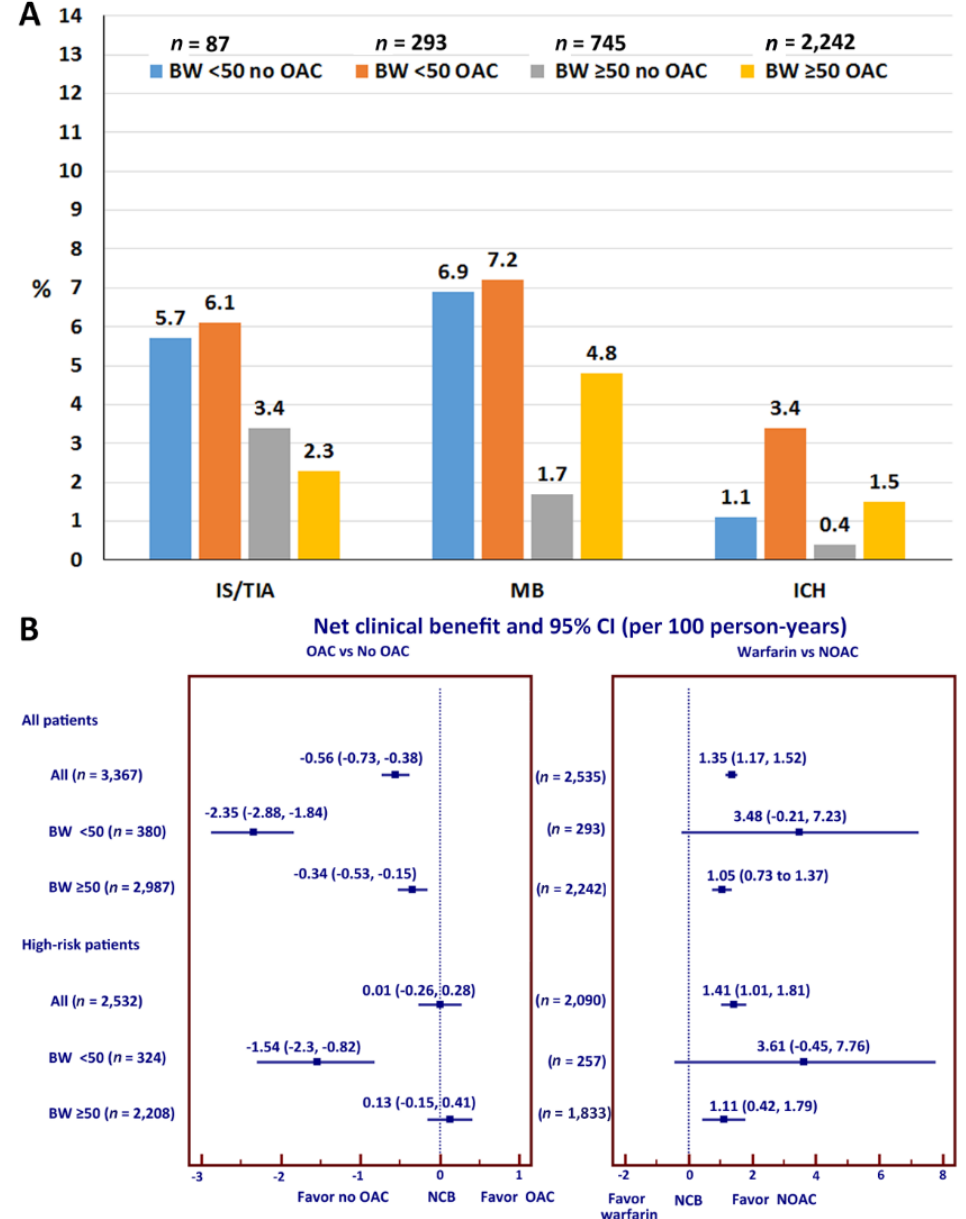
Figure 5. Oral anticoagulants and clinical outcomes. ( A ). Rates of ischemic stroke (IS)/transient ischemic attack (TIA), major bleeding (MB), and intracerebral hemorrhage (ICH) stratified by body weight (BW) and oral anticoagulation (OAC). The interaction p -values of OAC use for the effect of body weight on ischemic stroke/TIA, major bleeding, and ICH were 0.025, 0.871, 0.981, respectively. ( B ). Net clinical benefit (NCB) of OAC compared to no OAC (left) and warfarin compared to non-vitamin K antagonist oral anticoagulant (NOAC) (right). Forest plot and Cox proportional hazards model was used for analysis.